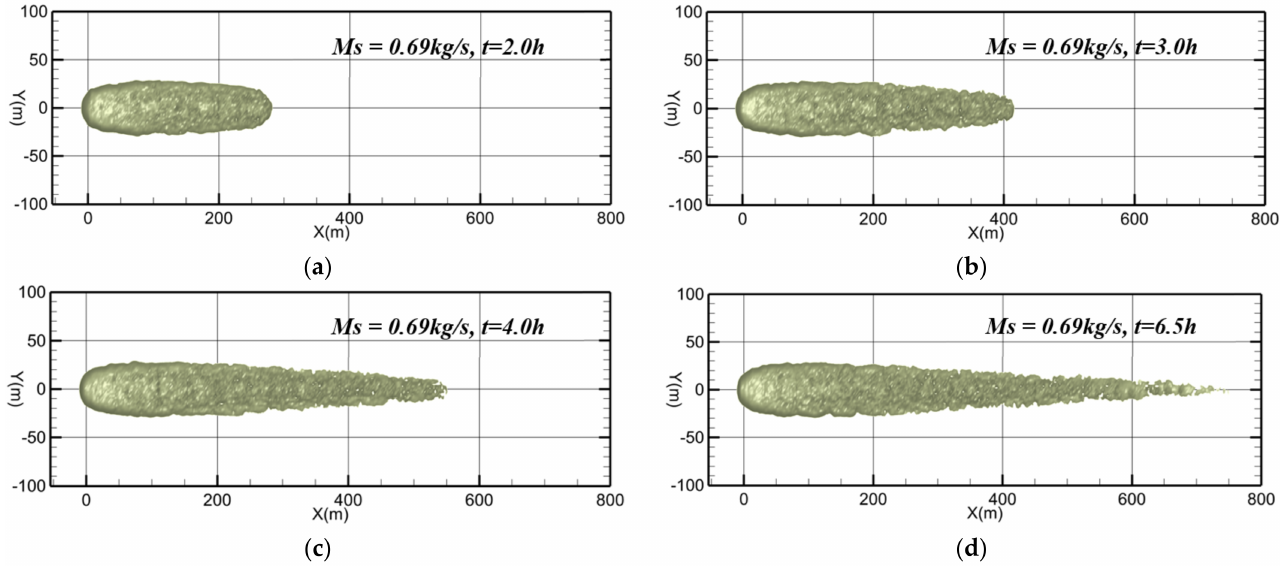
Figure 9. Evolution of the sediment sub-plume with an iso-surface of 63 mg/L during the discharging at the rate of 1.38 kg/s. ( a ) t = 2 h, ( b ) t = 3 h, ( c ) t = 4 h, and ( d ) t = 6.5 h.